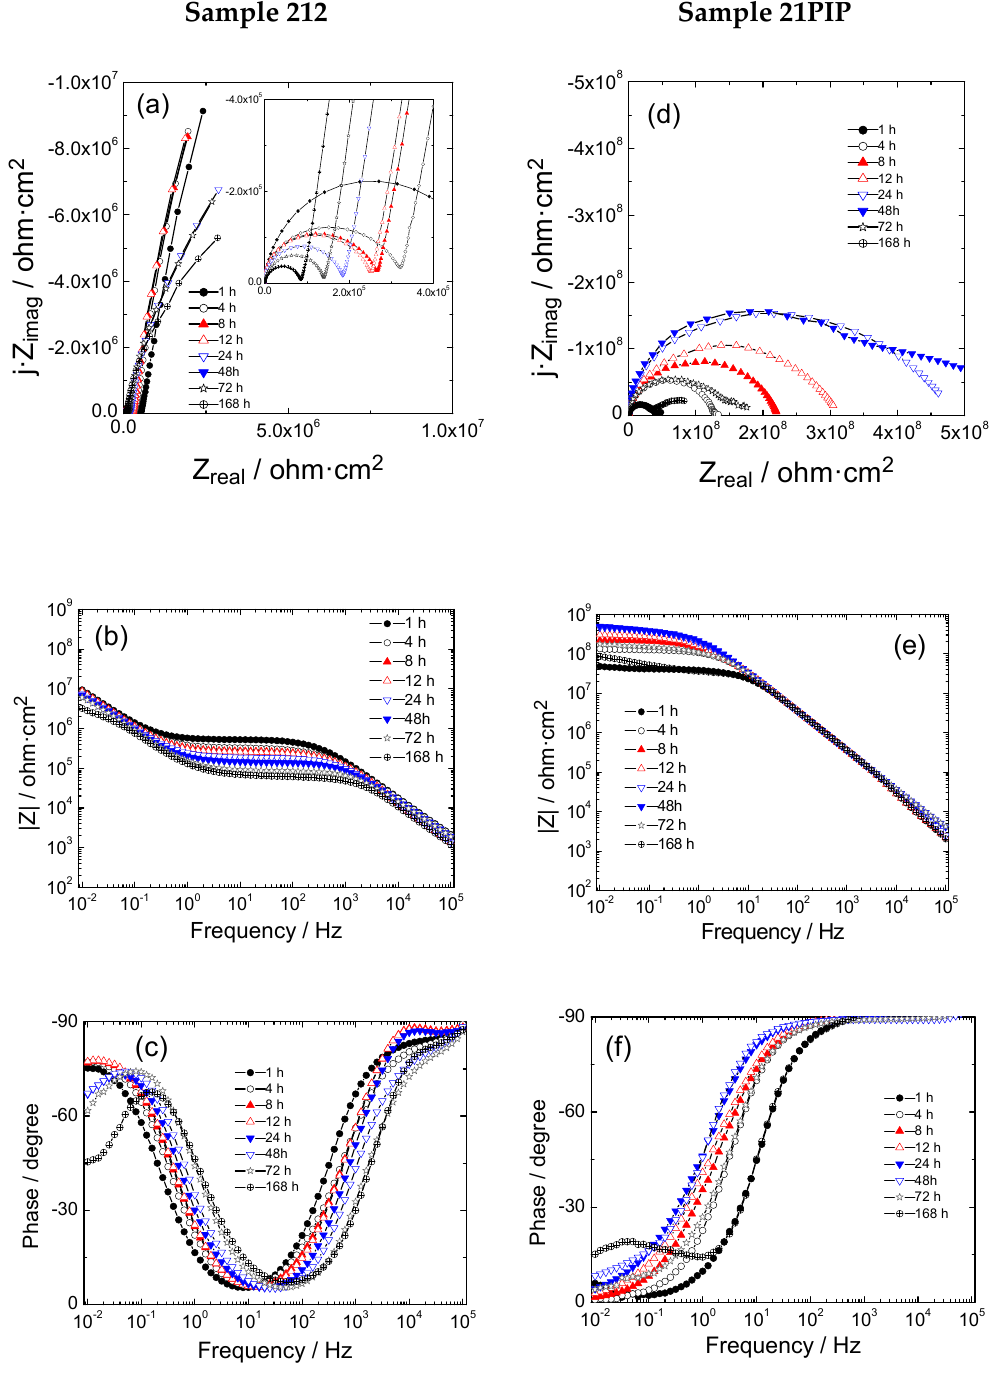
Figure 12. Nyquist and Bode impedance plots for different AA2024-T3/sol-gel coating systems: sample 212 (( a ), ( b ) and ( c )) and sample 21PIP (( d ), ( e ) and ( f )). Test electrolyte: 0.05 M NaCl aqueous solution. Immersion time: 1 h, 4 h, 8 h, 12 h, 24 h, 48 h, 72 h and 168h.